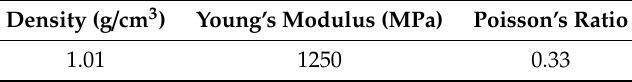
Table 2. Material properties of PA12